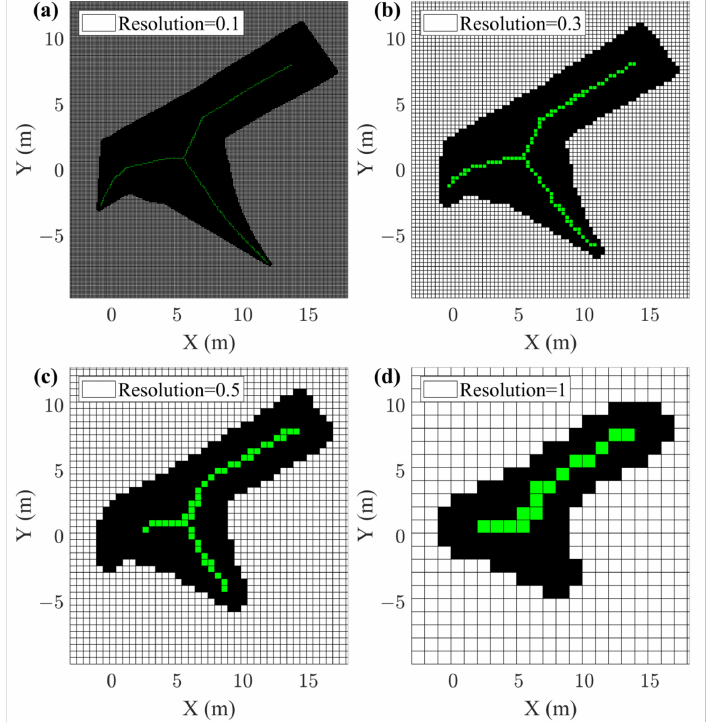
Figure 22. The binary map and its skeleton of the LiDAR data corresponding to Figure 13b under different map resolutions. The map resolution corresponding to ( a – d ) is 0.1, 0.3, 0.5, 1, respectively.